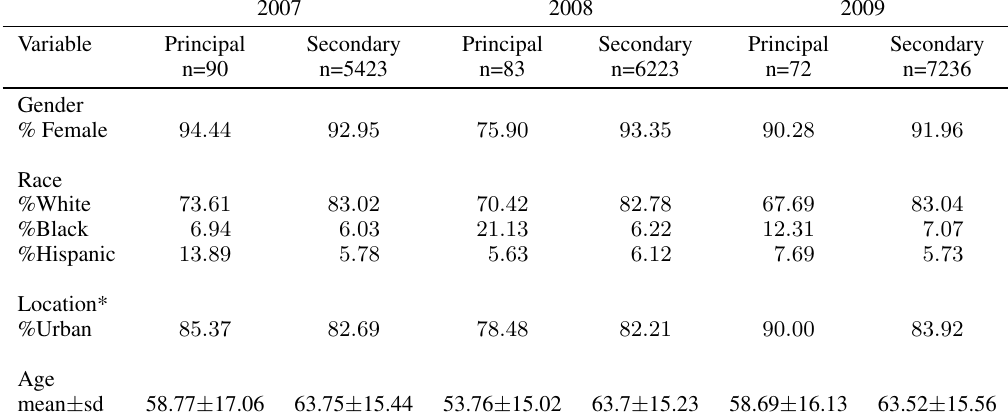
Table 1: Hospital admissions with SS as principal or secondary diagnosis by demographics and year of admission